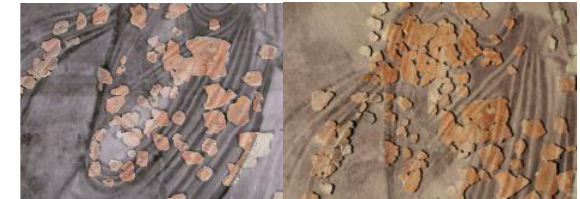
Figure 16. Result of the first mosaiking on enlarged photo and the 3D model at 1:1 scale (courtesy of ISCR and Werner Matthias Schmid)